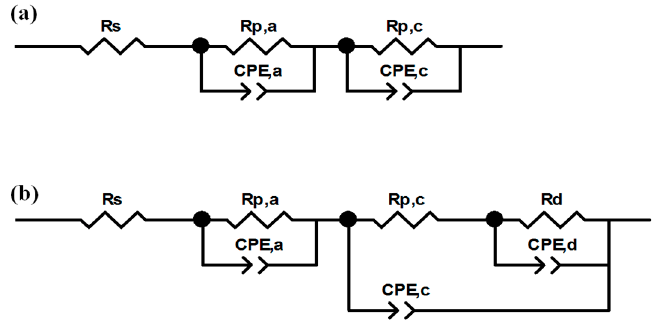
Figure 2. Equivalent circuits employed for getting electrochemical parameters from electrochemical impedance spectroscopy (EIS) experimental points: at low current ( a ); and at high current ( b ).